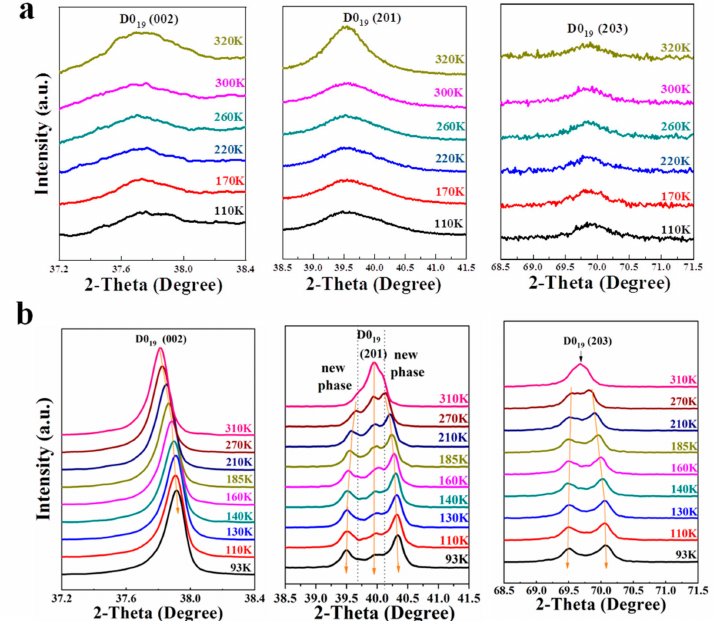
Figure 2. Comparison of conventional X-ray di ff raction (XRD) patterns between ( a ) bulk Ti 3 Sn sample and ( b ) Ti 3 Sn powder during the cooling process. ( a ) XRD peaks of bulk Ti 3 Sn near hexagonal D0 19 phase (002), (201) and (203) crystal faces. ( b ) XRD peaks of Ti 3 Sn powder near hexagonal D0 19 phase (002), (201) and (203) crystal faces,